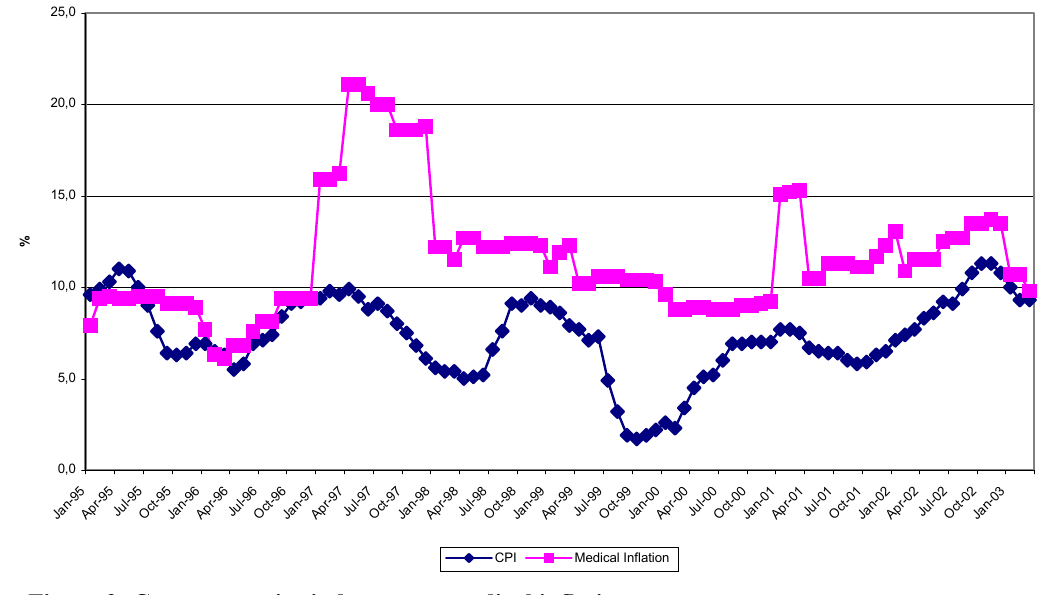
Figure 3: Consumer price index versus medical inflation Source: Council for Medical Schemes (www